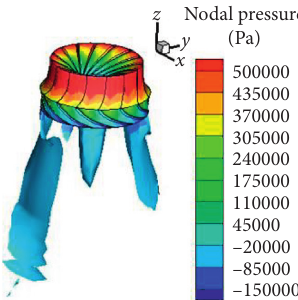
Figure 8: Shape of vortex rope in the draft